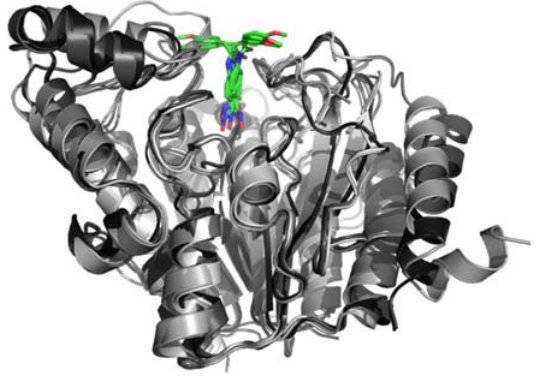
Figure 7. Models of Tg HDACs in complex with JF363. The best complexes for each of the five HDACs from T. gondii ME49 were superposed. The proteins are shown in grey ribbons and the ligand in colored sticks. The figure was drawn using Pymol (http://pymol.org, accessed on 20 February 2022).